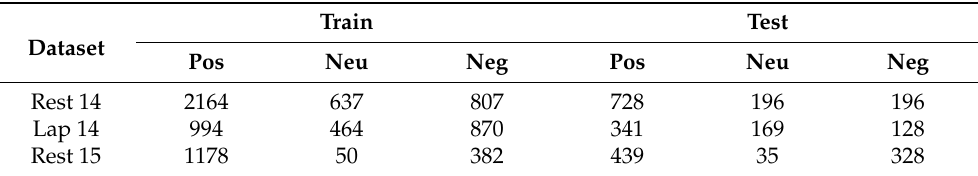
Table 1. Data sets.